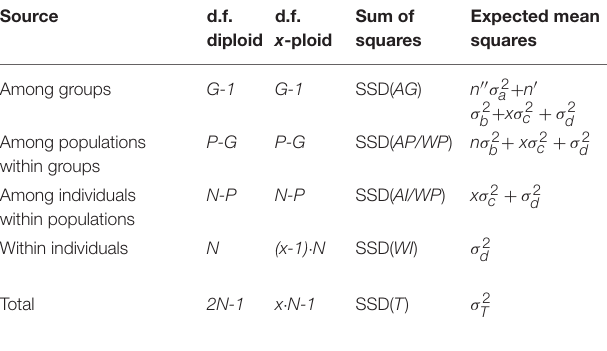
TABLE 2 | Outline of the AMOVA framework for multiple group of populations with the degrees of freedom (d.f.) both given for diploids and generalized for any ploidy level x (except